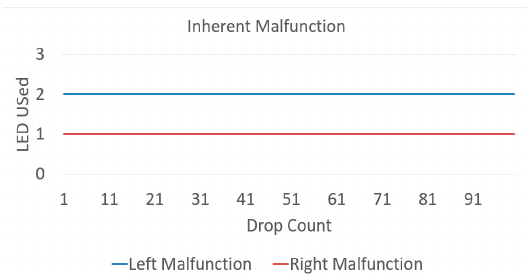
Figure 19. LED pair used during inherent malfunction.